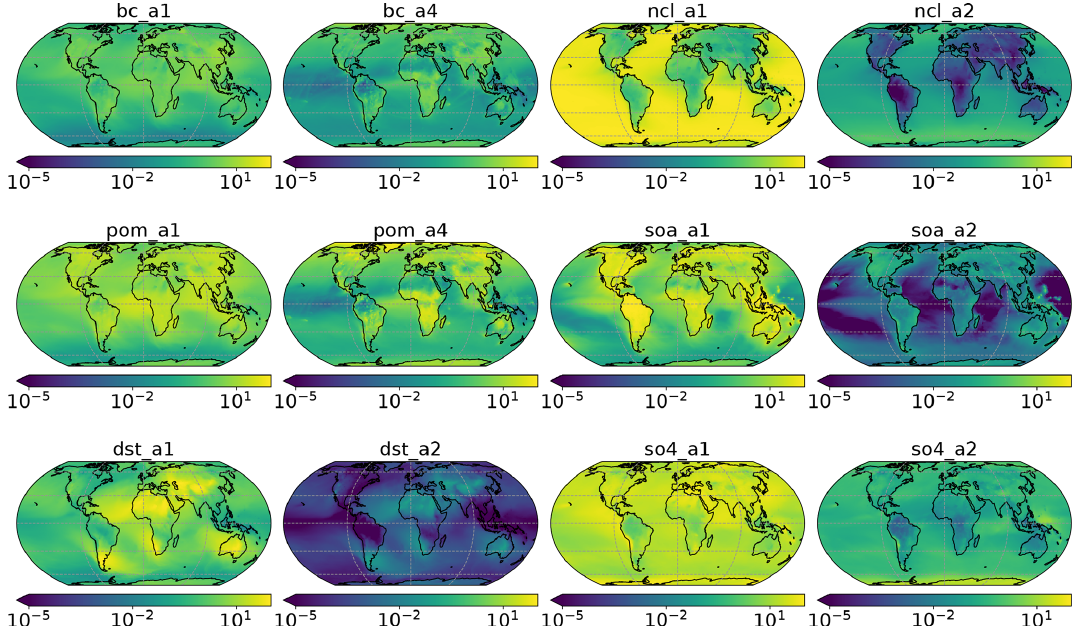
Figure A2. Fraction of aerosol species mixing ratio (%). Accumulation mode: a1; Aitken mode: a2; primary carbon mode: a4. The coarse mode (a3) is not used in this study and therefore omitted in this figure. Black carbon: bc; dust: dst; sea salt: ncl; primary organic matter: pom; secondary organic aerosol: soa; sulfate: